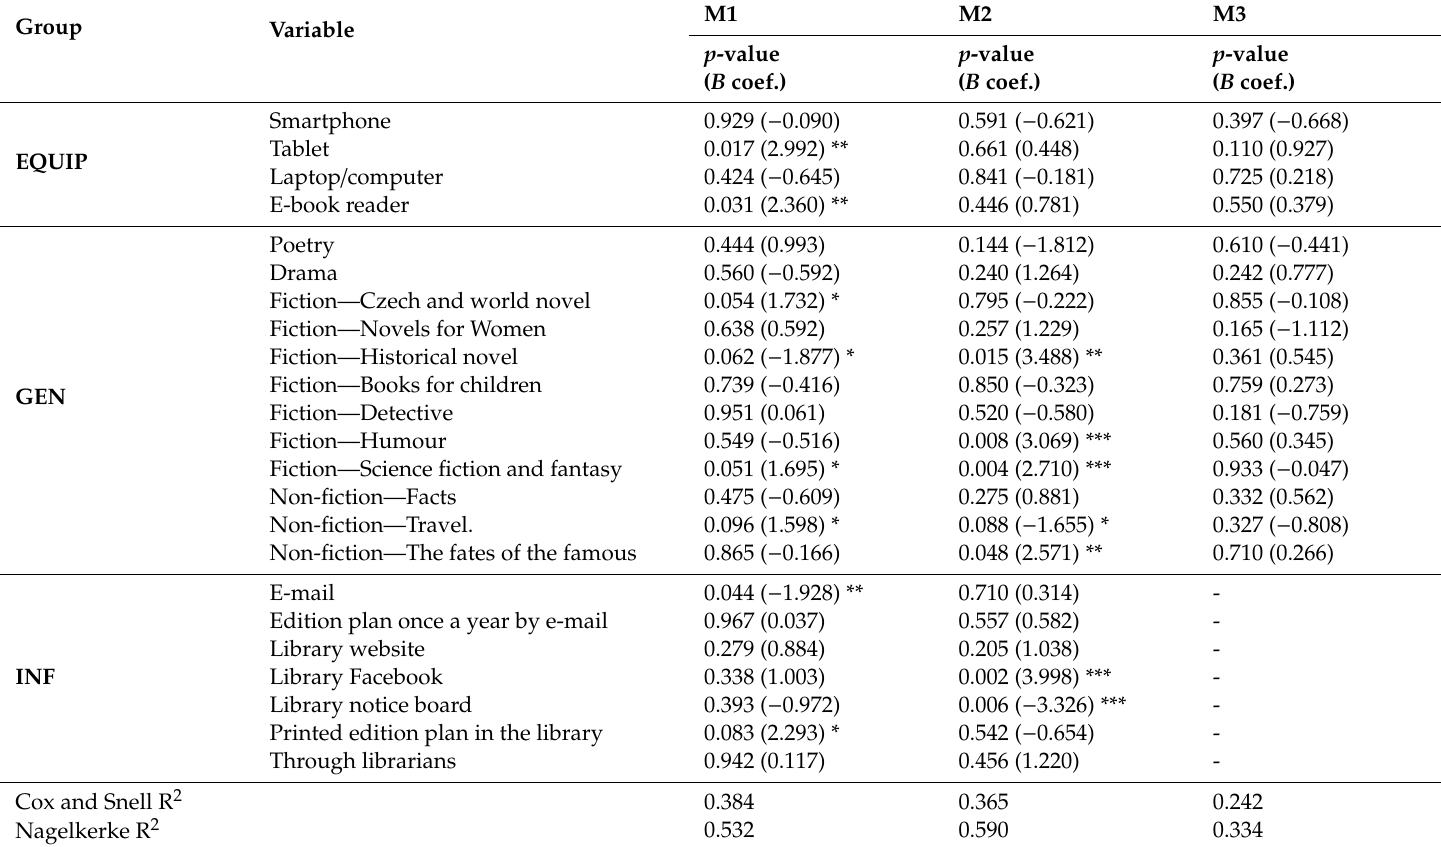
Table 4. The readers of e-books: